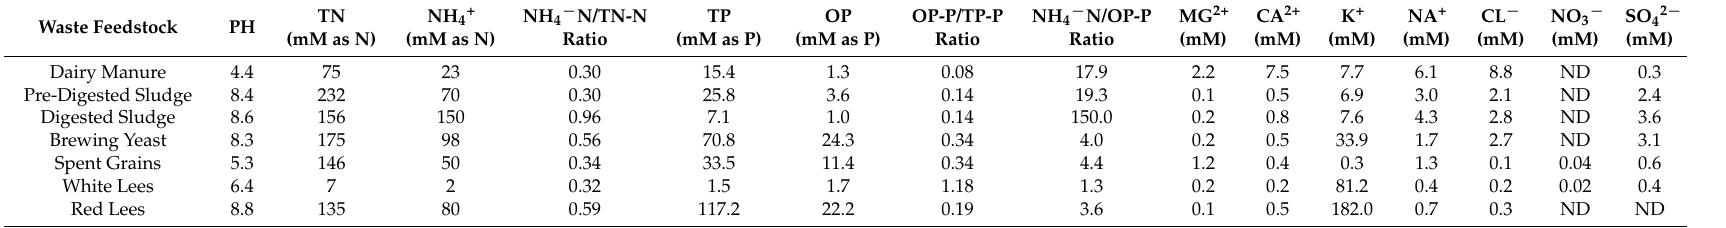
Table 1. Characterization of post-hydrothermal liquefaction (HTL) aqueous co-product (ACP) of select waste feedstocks for pH and various wastewater constituents. Average values are reported and used as inputs for modeling and experimental analysis. ND denotes measurements below the detection limit of 0.5 mg/L. All samples exhibited ND nitrite (NO 2 −